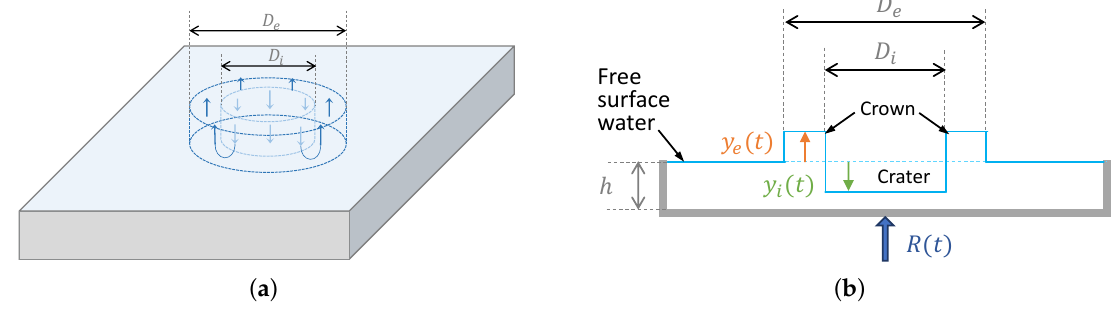
Figure 12. Schematic of the simplified splashing mechanism: ( a ) 3D view; ( b ) 2D